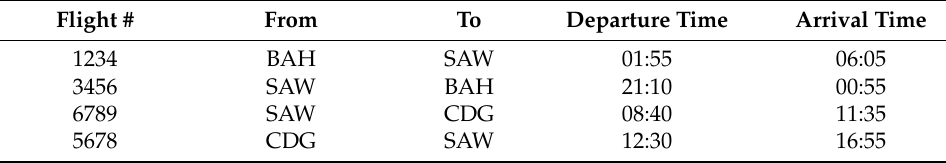
Figure 3. Detailed pseudocode for finding initial solution (Phase 1). Table 1. Data for the numerical example.